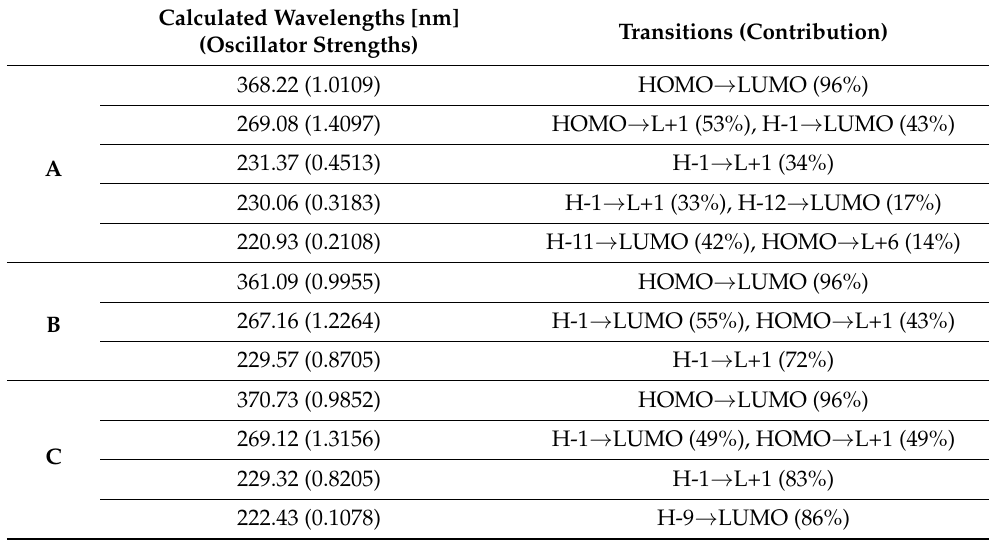
Table 5. The calculated absorption spectra by the TD-DFT method (6-31G(d,p)/CAM-B3LYP) with oscillator strengths for A – C .